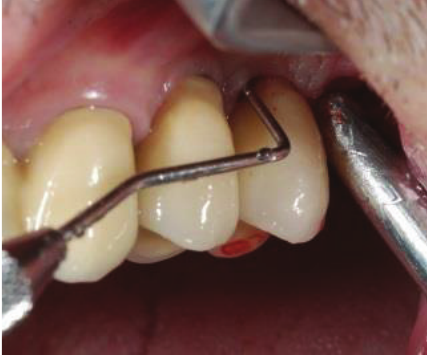
Figure 2: Initial probing revealed a deep peri-implant pocket between 2 short, single-crown locking taper implants, in positions 12 and 13.